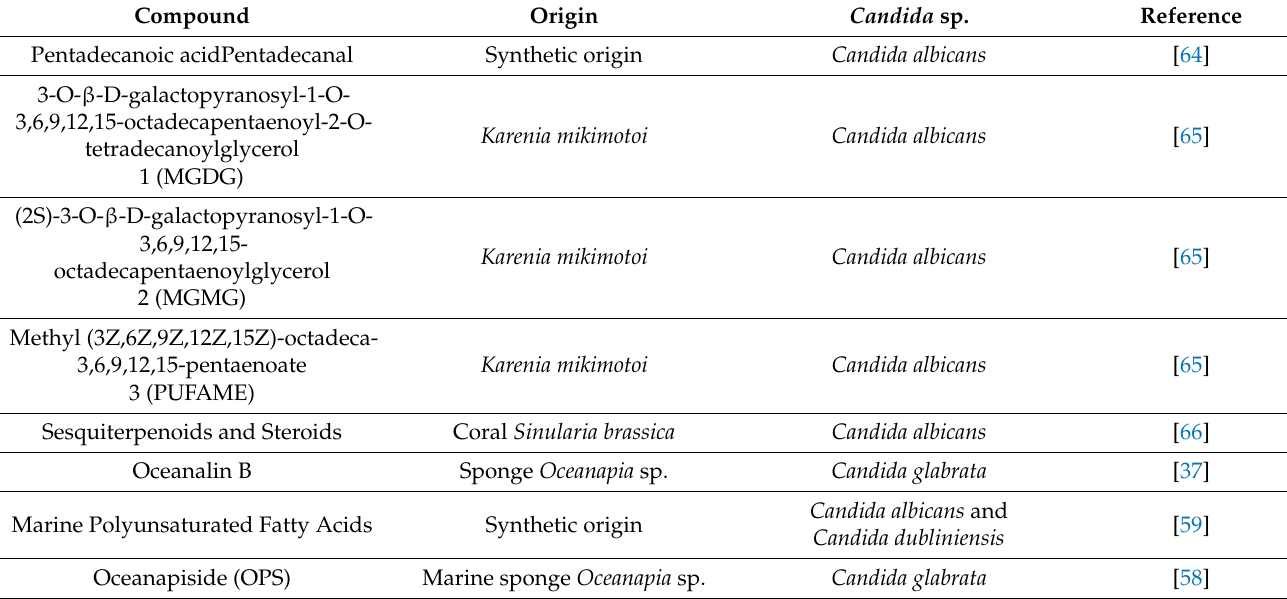
Table 4. Antifungal activity of fatty acids and lipids of marine